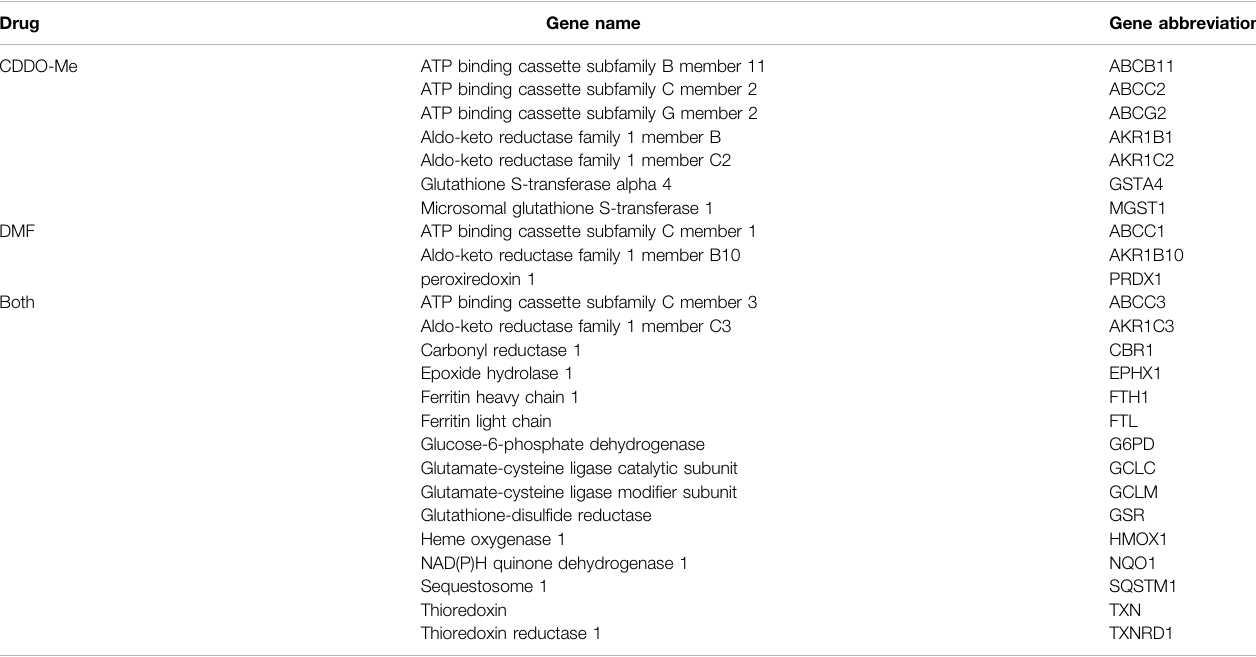
TABLE 1 | Drug speci fi c cytoprotective gene induction in HMVEC. Drug